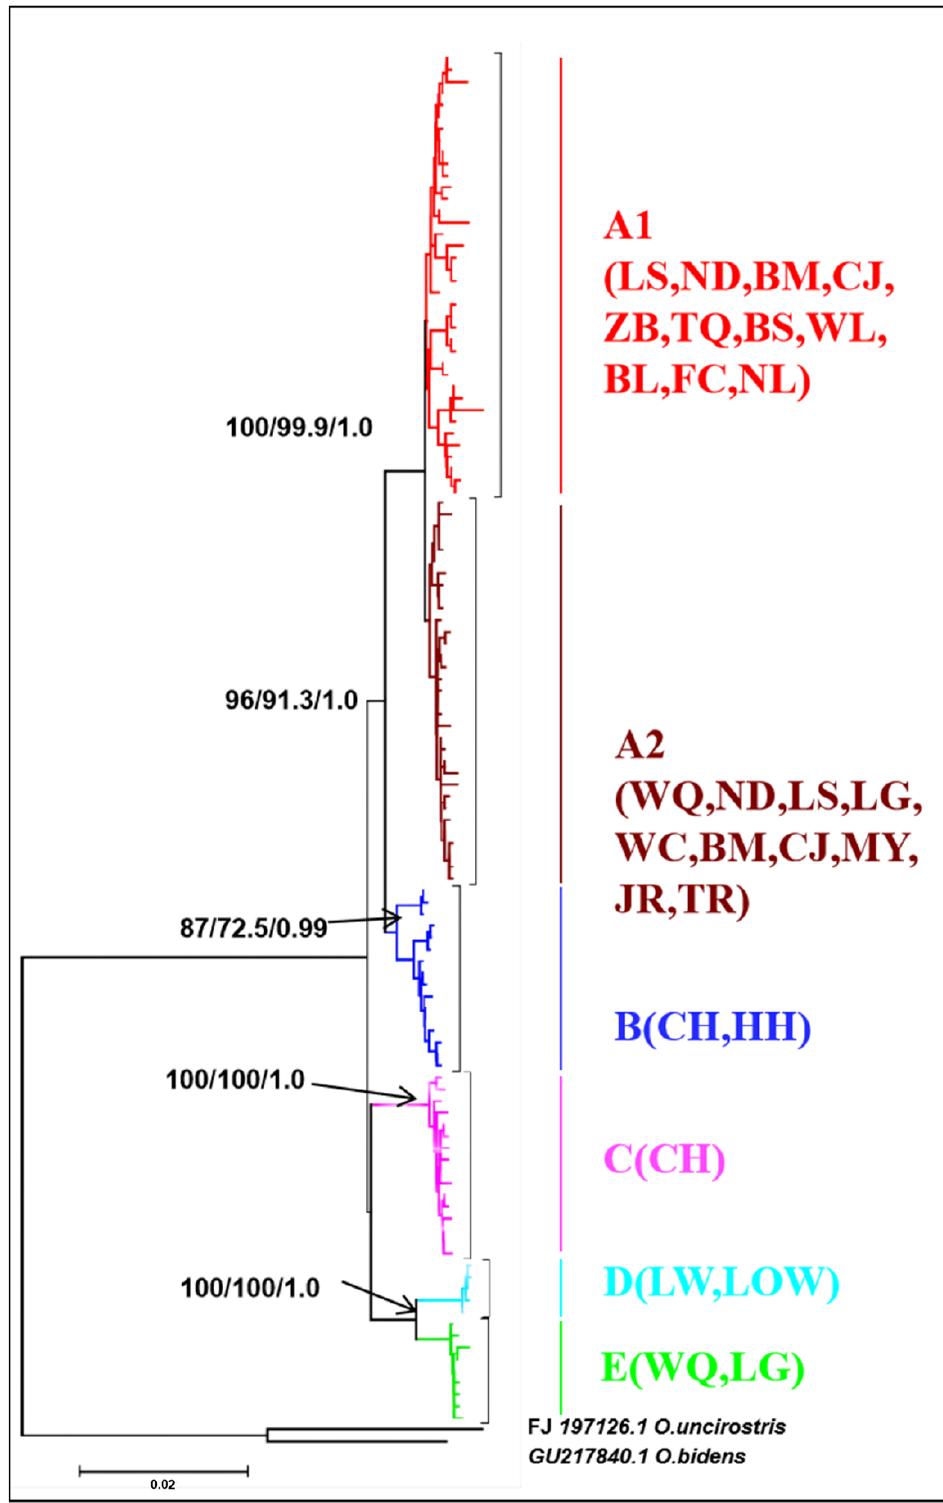
Figure 3. NJ tree of genetic relationships based on mitochondrial cyt b + D-loop gene among 21 populations in O. hainanensis using 117 haplotypes. The values above the branches are the posterior probabilities for bootstrap values for the NJ, ML, and Bayesian analyses. O. bidens and O. uncirostris are two species in the genus Opsariichthys used as an outgroup.